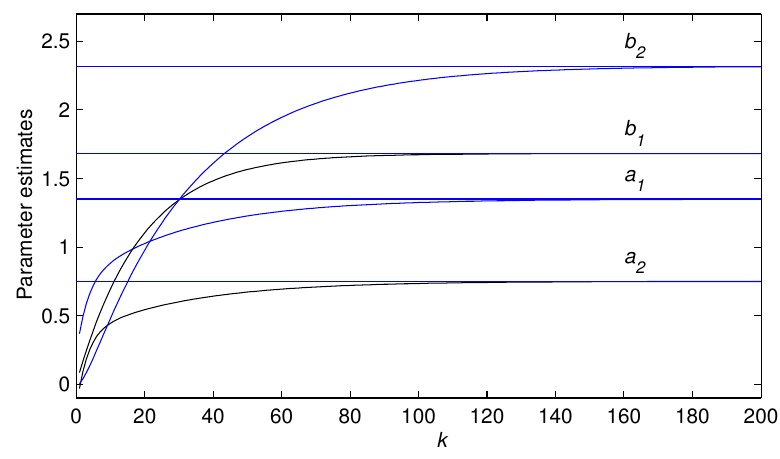
Figure 5. The GI estimates versus k with σ 2 = 0.20 2